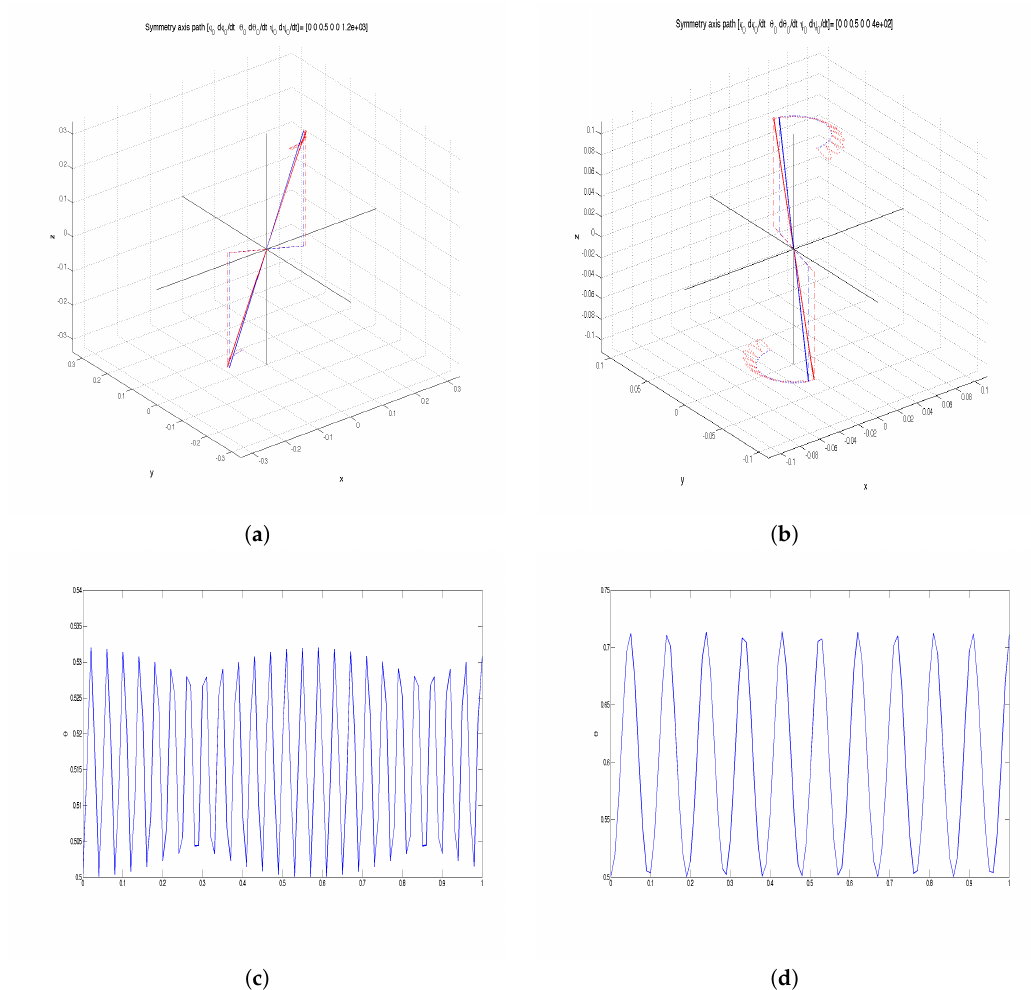
Figure 4. Gyroscopic movements: ( a ) 1200 rad/s rotating mass; ( b ) 400 rad/s rotating mass. ( c ) Regulated set point θ = 0.5 rad and 1250 rad/s; ( d ) regulated set point θ = 0.5 rad and 400